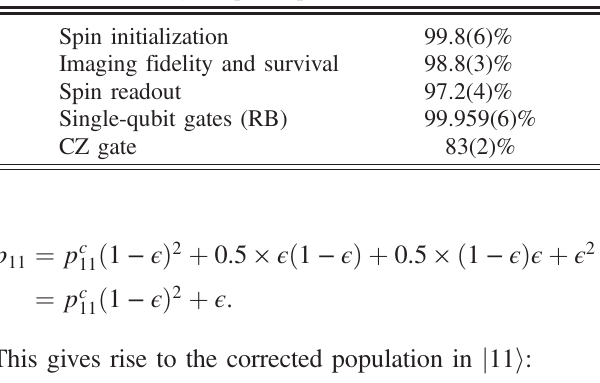
TABLE II. Fidelity of qubit